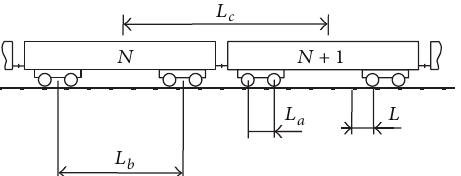
Figure 7: Rudimentary geometrical parameters of the train and the